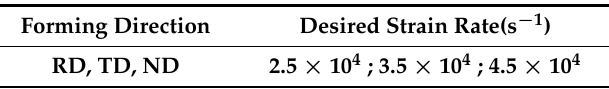
Table 2. SHPB tests conditions.